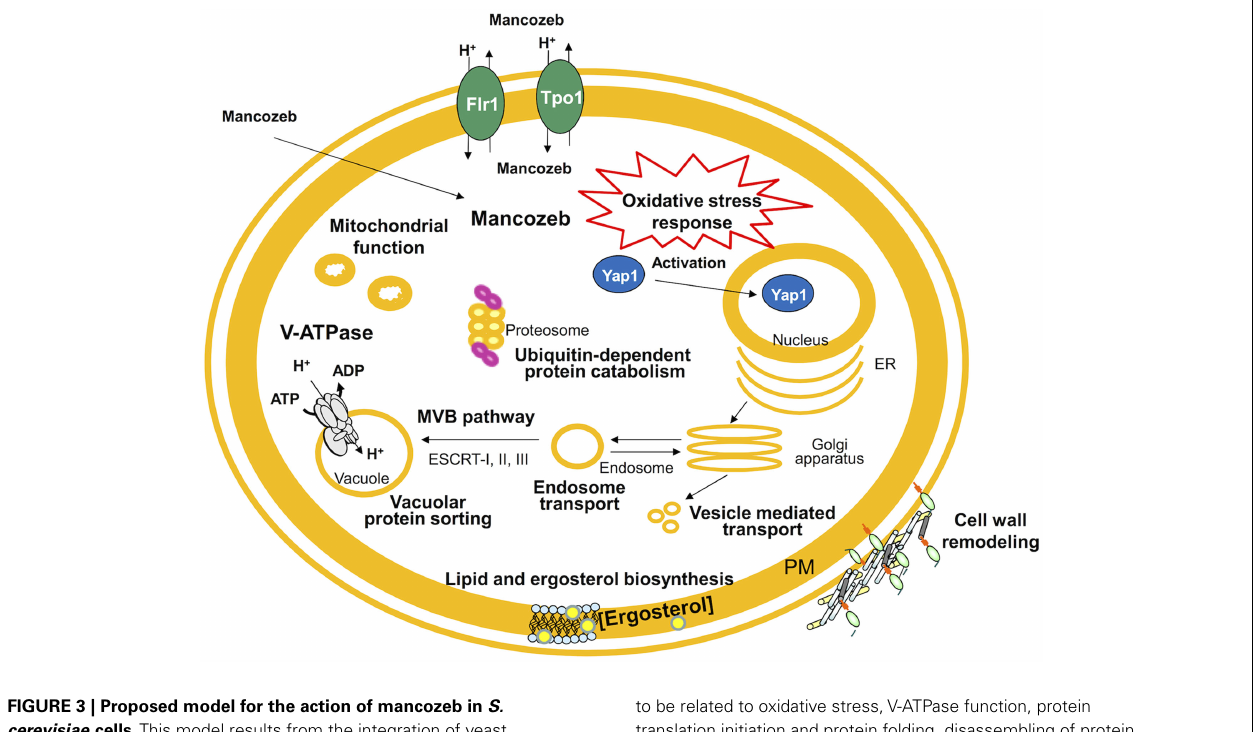
FIGURE 3 | Proposed model for the action of mancozeb in S. cerevisiae cells. This model results from the integration of yeast chemogenomics (Dias et al., 2010) and proteomics (Santos et al., 2009) approaches.The complex mancozeb-induced expression changes and mancozeb determinants of yeast resistance, were found